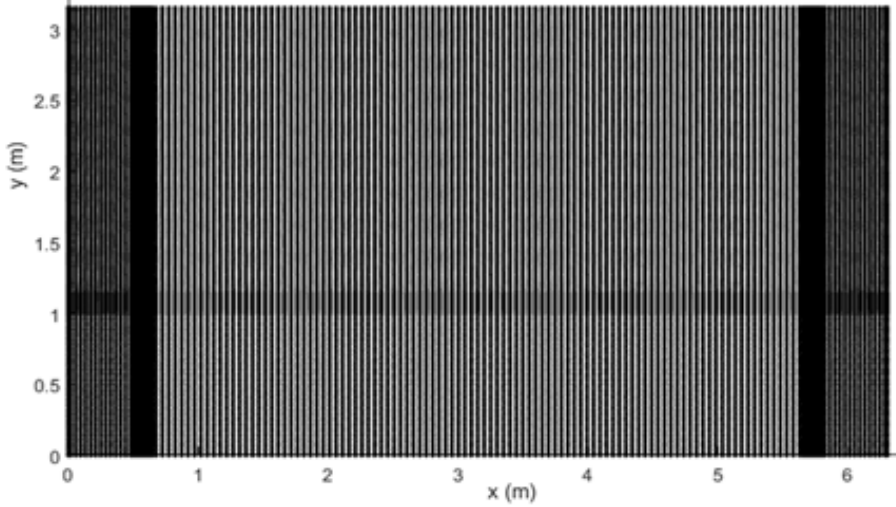
Figure 5. Distribution of nodes in the domain (mesh).